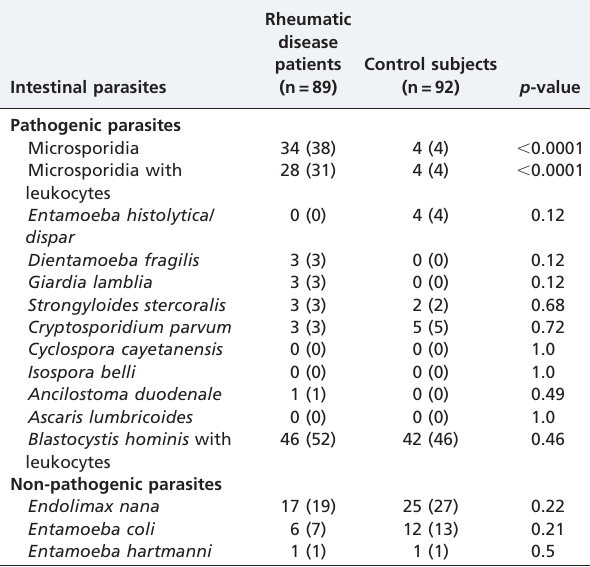
Table 1 - Intestinal parasites in rheumatic disease patients undergoing anti-TNF/DMARD therapies and healthy controls.